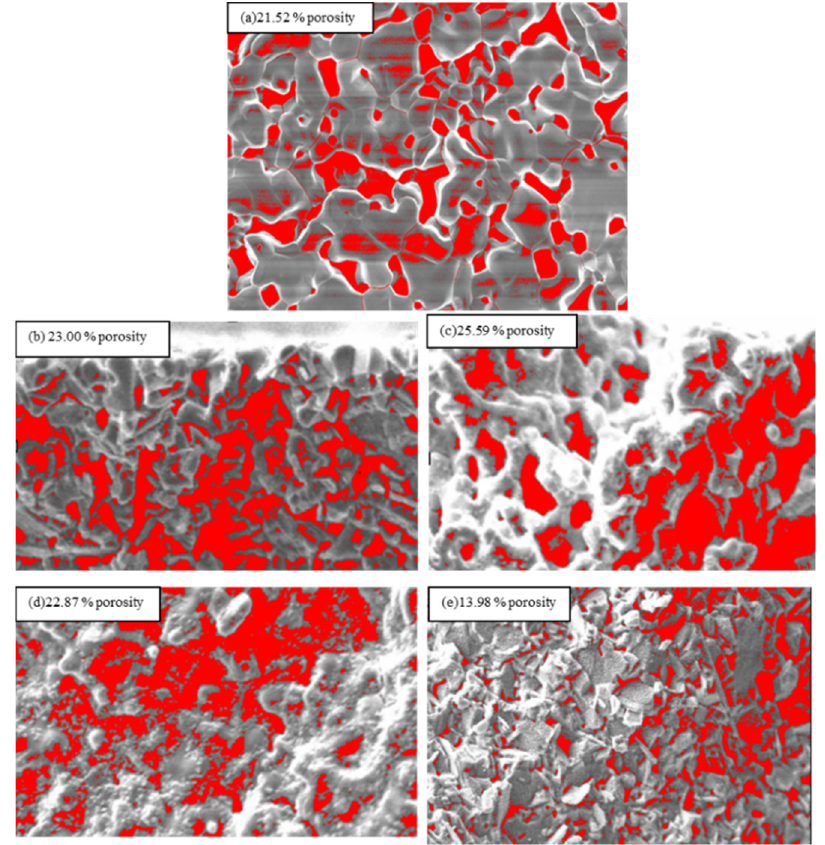
Figure 4. Porosity for ( a ) 1× printing, ( b ) 3× printing, ( c ) 5× printing, ( d ) 7× printing, and ( e ) 9× printing calculated using ImageJ software.